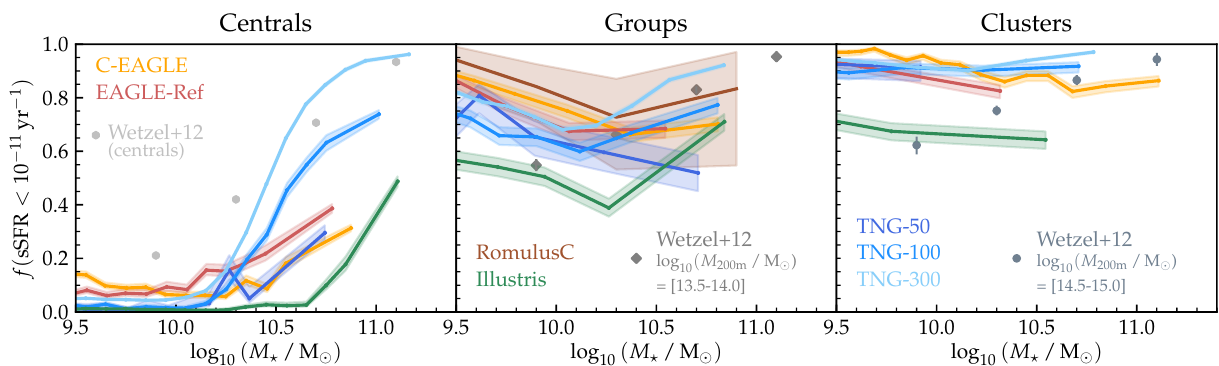
Figure 15. Quenched fractions f q of central galaxies ( left ) and of satellites in groups ( M 500 = 10 13 clusters ( M 500 > 10 14 M , ( right )) as predicted by different simulations. For (C-)EAGLE, Illustris, and IllustrisTNG, these are (cid:12) computed directly from the simulation outputs; the quenched fractions for RomulusC are taken from Tremmel et al. [49]. Especially on the low stellar mass end ( M (cid:63) (cid:46) 2 10 10 M ), different simulations agree closely for centrals ( f q × (cid:12) clusters ( f q 1), whereas predictions on group scales show a much larger diversity ( f q between 0.6 and 1). Observational ≈ data from Wetzel et al. [11] are shown for approximate guidance, but neither the satellite selection nor the host mass ranges are matched to their